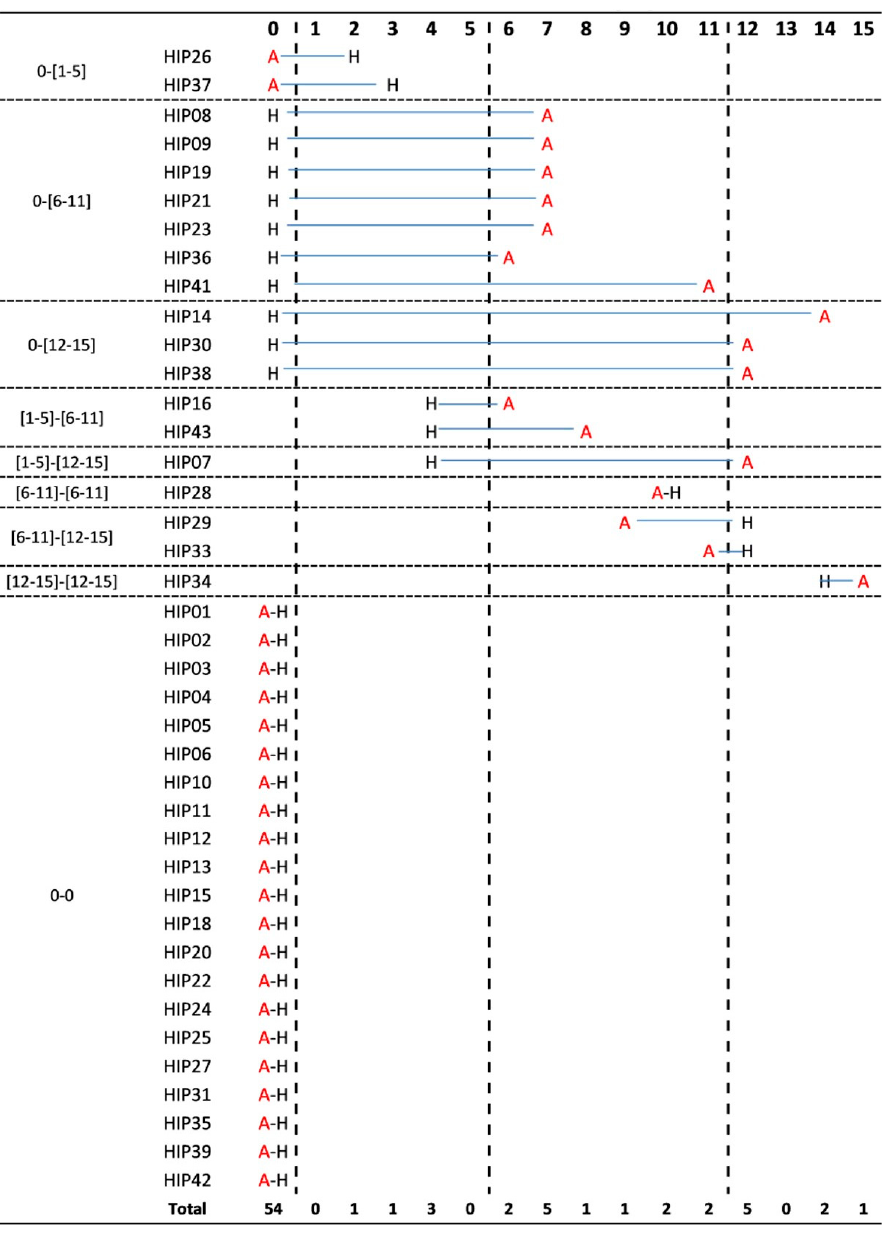
Figure 2. Anterior cup overhanging on the axial view at the superior edge of the cup in the same case according to the two configurations AHCR (A) and HHCR (H). Anterior cup overhanging on the axial view in the middle of the superior half of the cup did not occur in 16 (40%) AHCR and 29 (72.5%) HHCR cases. Cups protruding 6–11 mm totaled 17 (42.5%) in the AHCR cohort and 6 (15%) in HHCR group, whereas only one (2.5%) ACHR socket protruded more than 12 mm. There was a moderate agreement between the two configurations (k = 0.32, p < 0.001) and a significant difference between the two configurations ( p < 0.001) [Figure